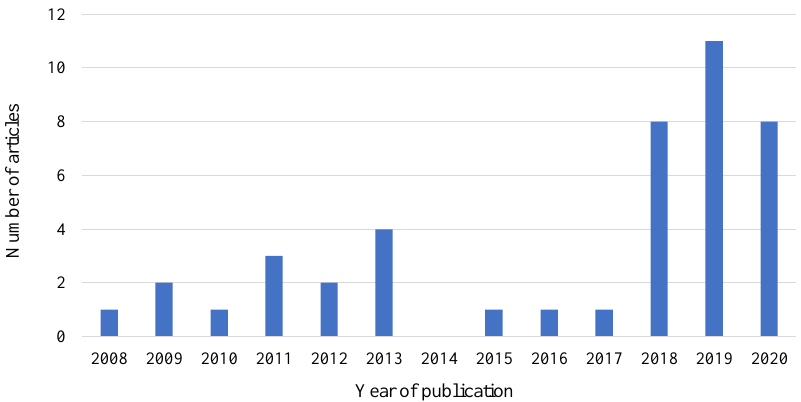
Figure 2. Research timeline. Source: personal elaboration by the authors.